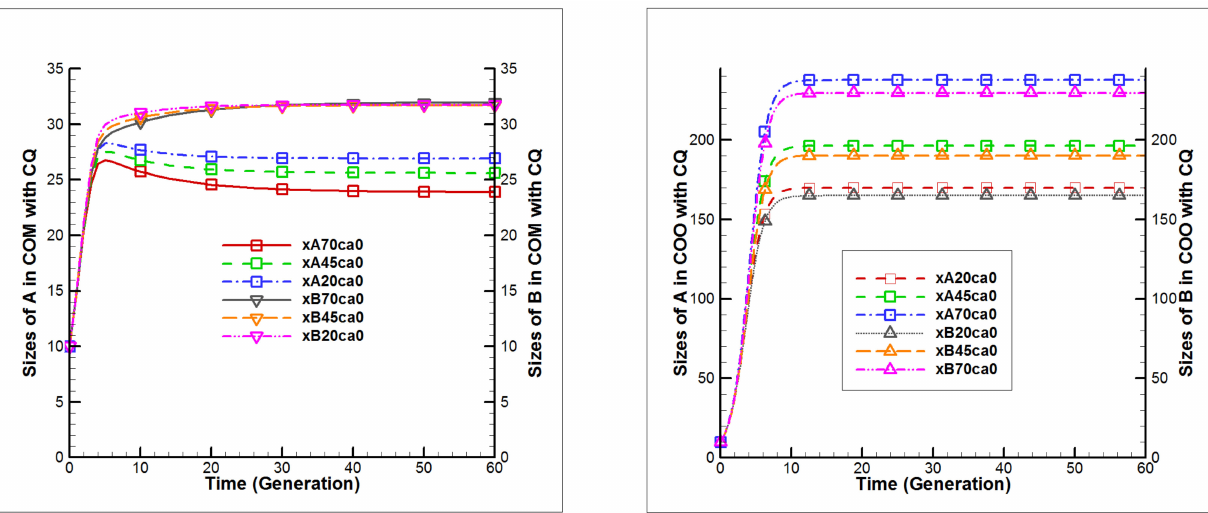
Figure 4. Evolution trajectories for player population sizes in case 2. (Note: ca0 is case 2; 20, 45, and 70 equal different entanglement intensities; Coo and Com are cooperation and competition coexistence, respectively; xA20 and xB20, xA45 and xB45, and xA70 and xB70 are the evolution trajectories of player A and B population sizes with entanglement intensity 20 ◦ , 45 ◦ and 70 ◦ ,